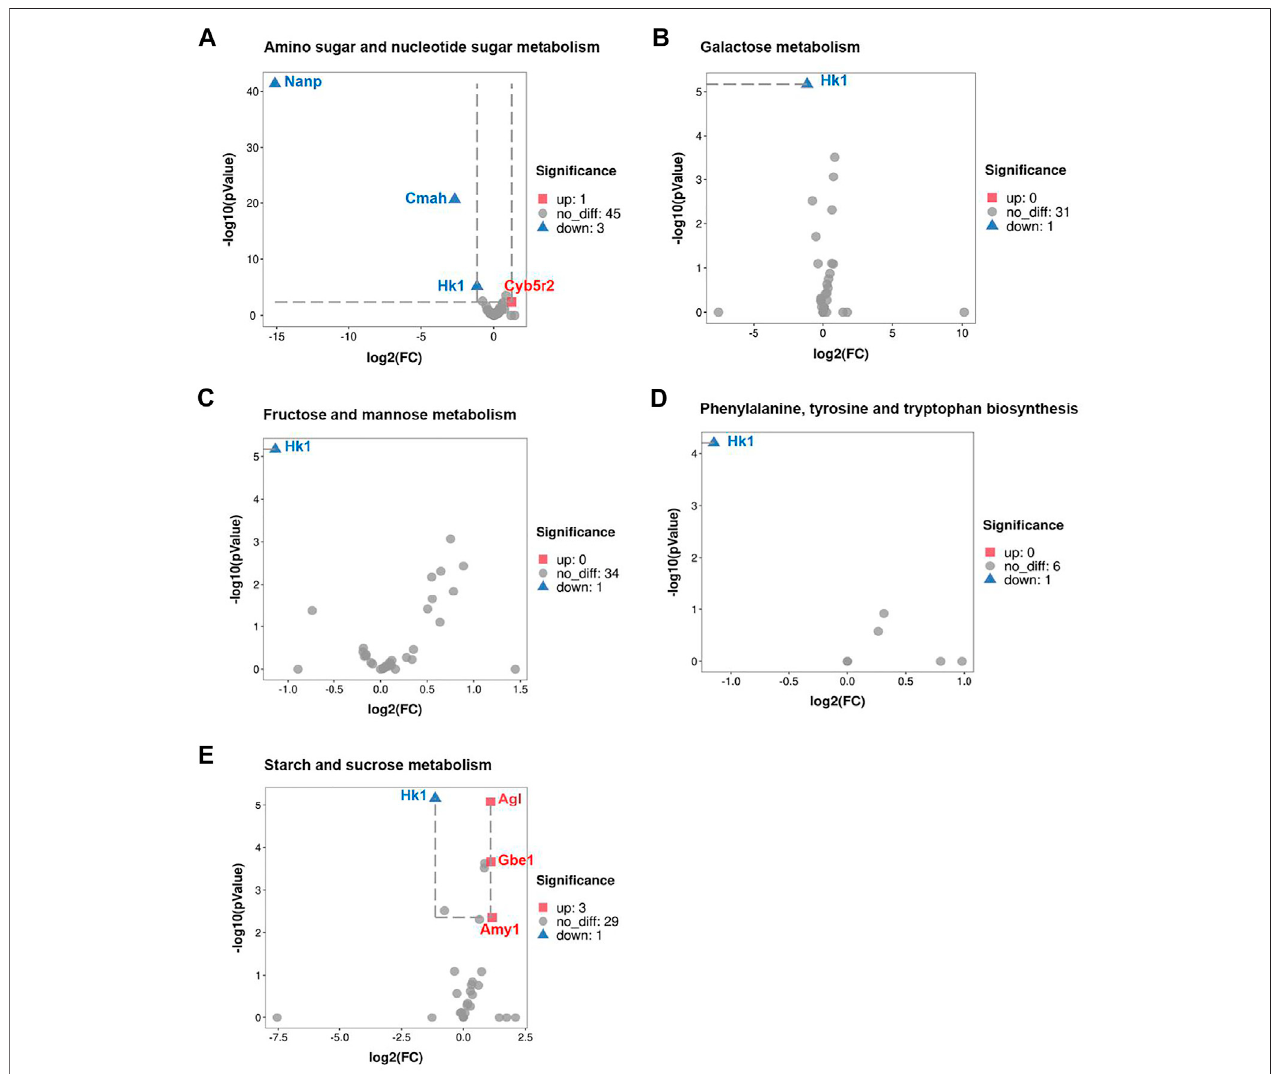
FIGURE 4 | CRS signi fi cantly affects genes expression associated with primary metabolites. (A) Volcano plot showed regulation of genes expression in amino sugar and nucleotide sugar metabolism. Signi fi cantly DEGs were labeled. FC is for gene expression fold change in CRS group compared to control group. The DEGs wereselectedwithfoldchange > 2orfoldchange < 0.5and p value < 0.05. (B) Volcanoplotshowedregulationofgenesexpressioningalactosemetabolism. (C) Volcano plot showed regulation of genes expression in fructose and mannose metabolism. (D) Volcano plot showed regulation of genes expression in phenylalanine, tyrosine and tryptophan biosynthesis. (E) Volcano plot showed regulation of genes expression in starch and sucrose metabolism.